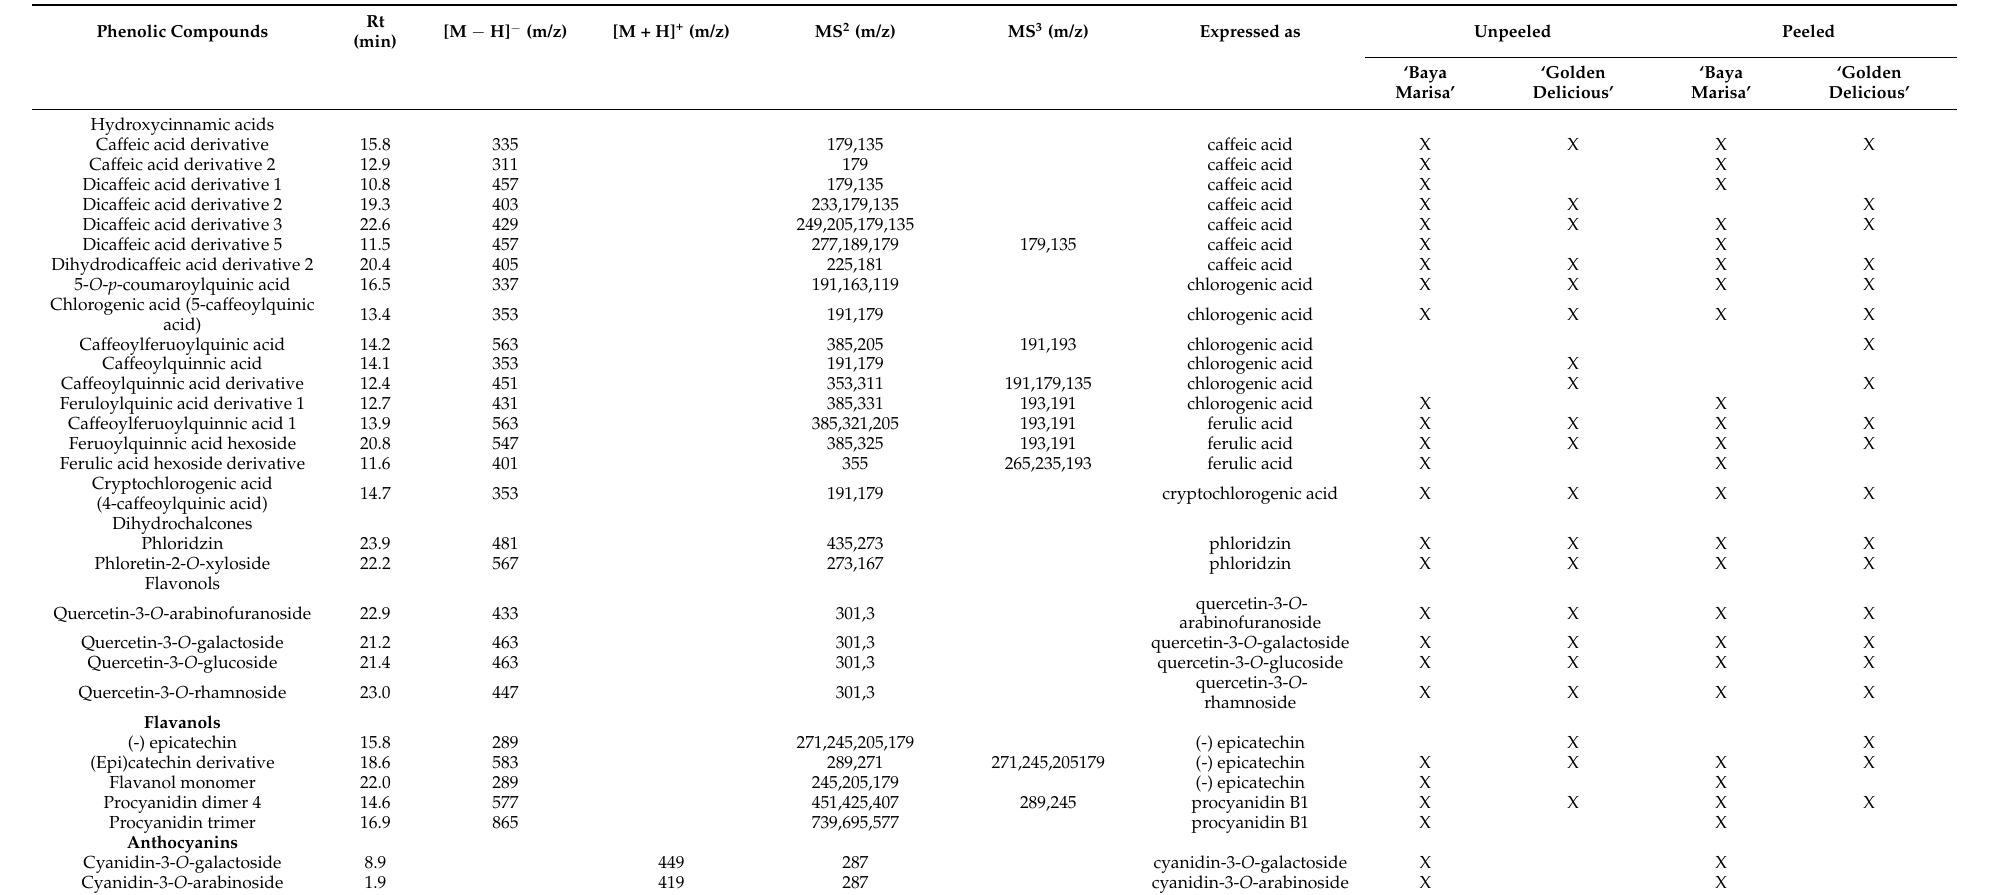
Table 2. Tentative identification of the 30 phenolic compounds of dehydrated apple slices of Malus domestica Borkh. cultivars ‘Baya Marisa’ and ‘Golden Delicious’ and used